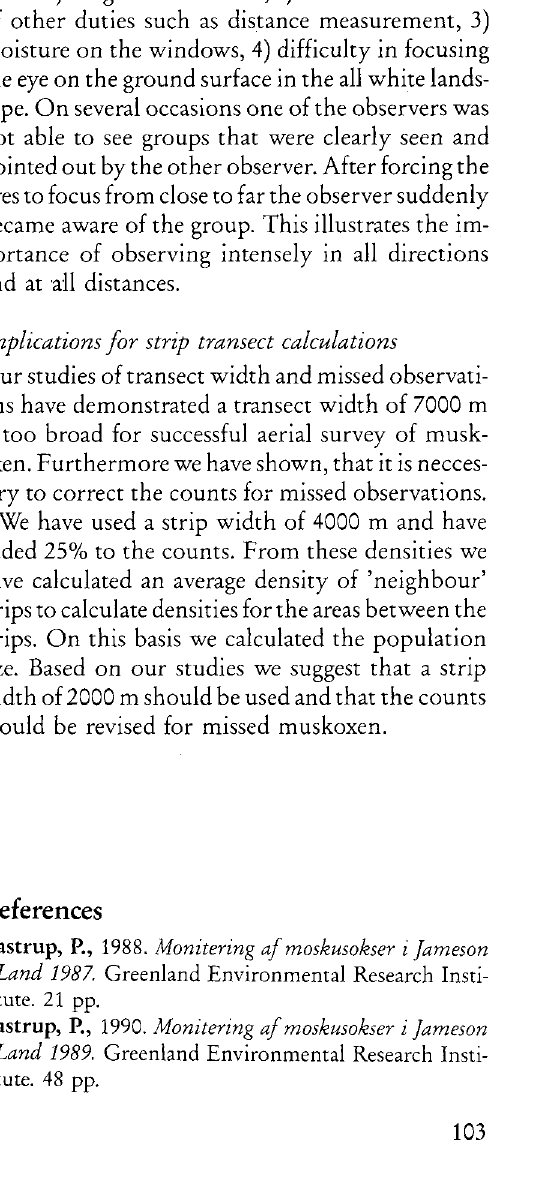
Fig. 7. Ratio between percentage of missed and observed groups in relation to group size and observation